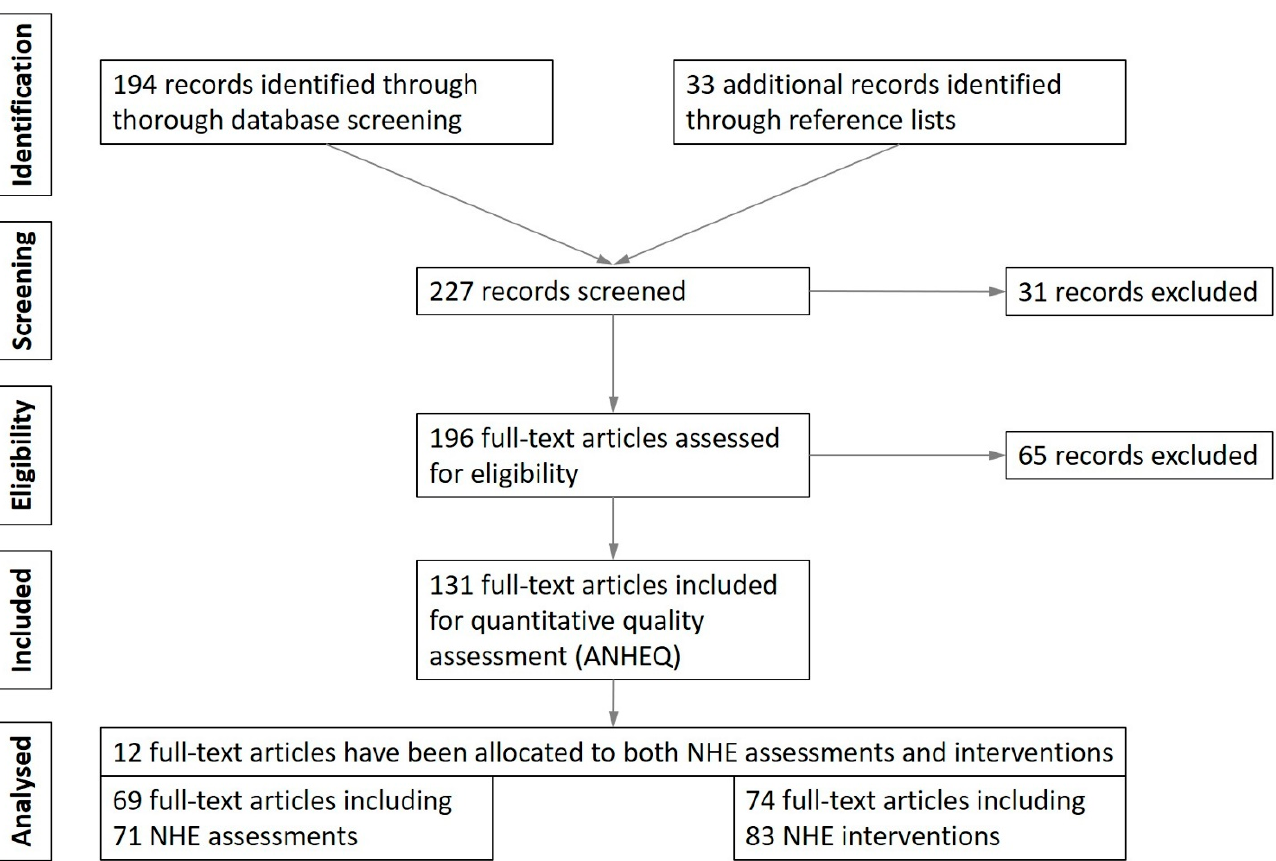
Figure 1. Flow chart of study identification, screening, and selection for the quantitative analysis of the quality of Nordic Hamstring Exercise (NHE) assessments and interventions.